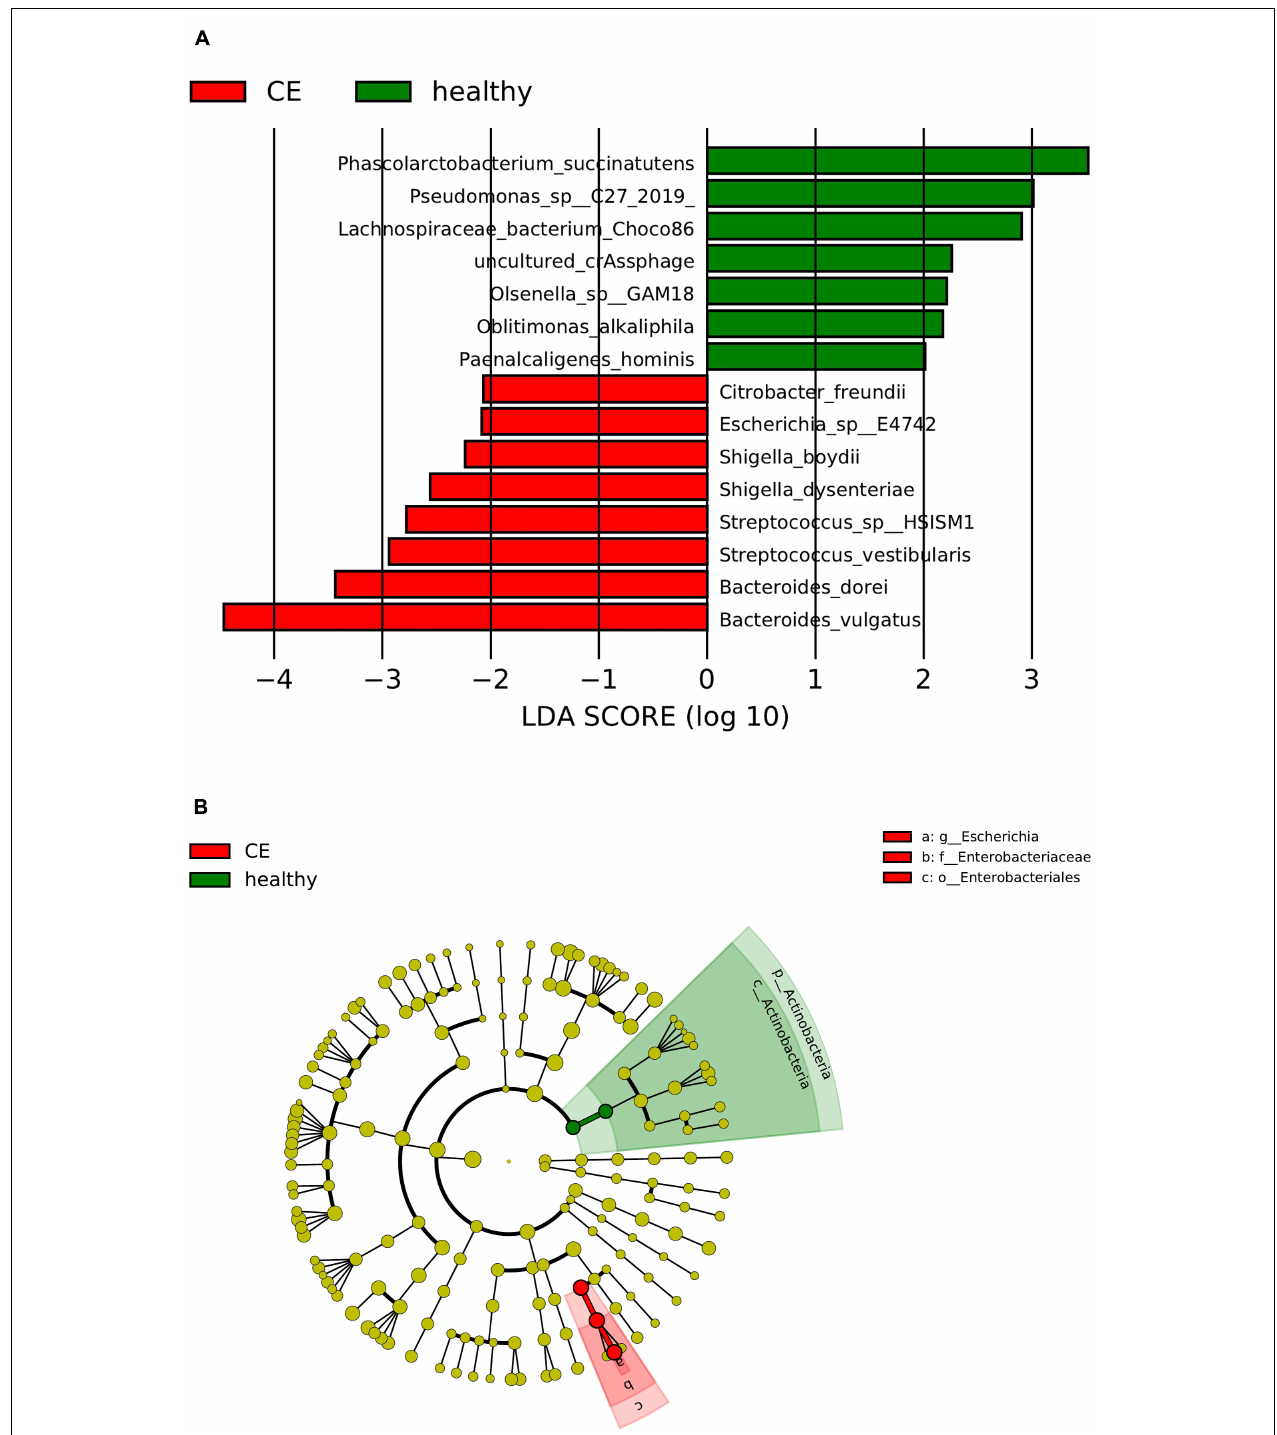
FIGURE 3 | Panel (A) is the histogram of distribution with linear discriminant analysis (LDA) value ≥ 2. Panel (B) shows the evolutionary cladogram. Histogram of linear discriminant analysis (LDA) effect size (LEfSe) value distribution and evolutionary cladogram between patients with cystic echinococcosis (CE) and healthy individuals. (B) . The cladogram the red and green nodes represented specific microorganisms relevant to healthy and CE patients of a cladogram. Each node represents a biomarker. The yellow nodes represent the microorganisms that did not play an important role in the different groups. The diameter of each node is proportional to the taxon’s abundance. The circles that radiate from the inside to the outside represent the classification level from phylum to species (o, order; f, family; g, genus; s, species).